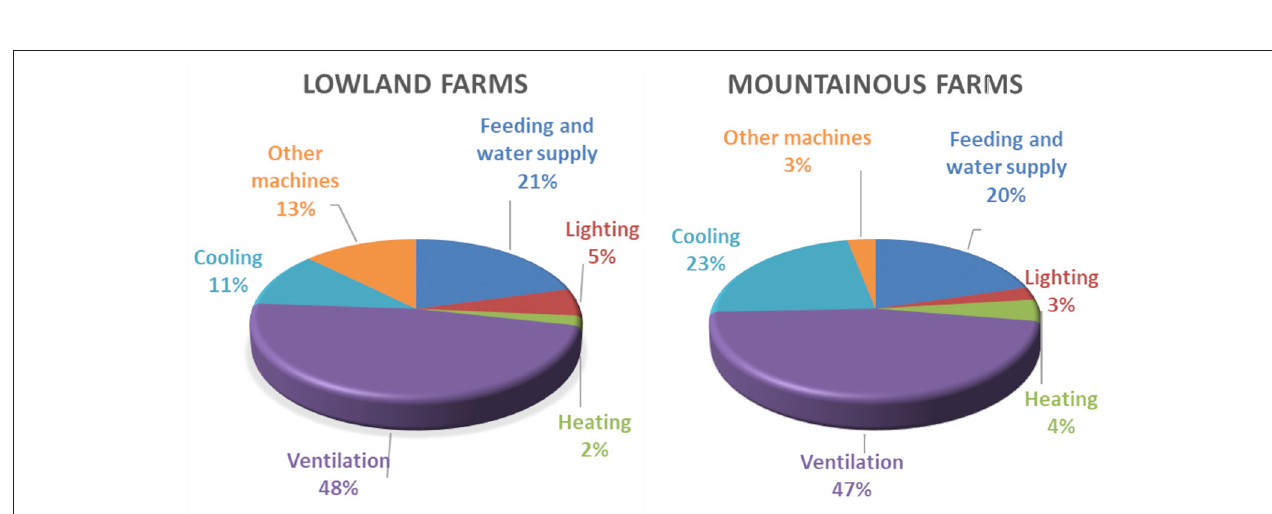
FIGURE 4 | Installed electrical power distribution in lowland and mountainous